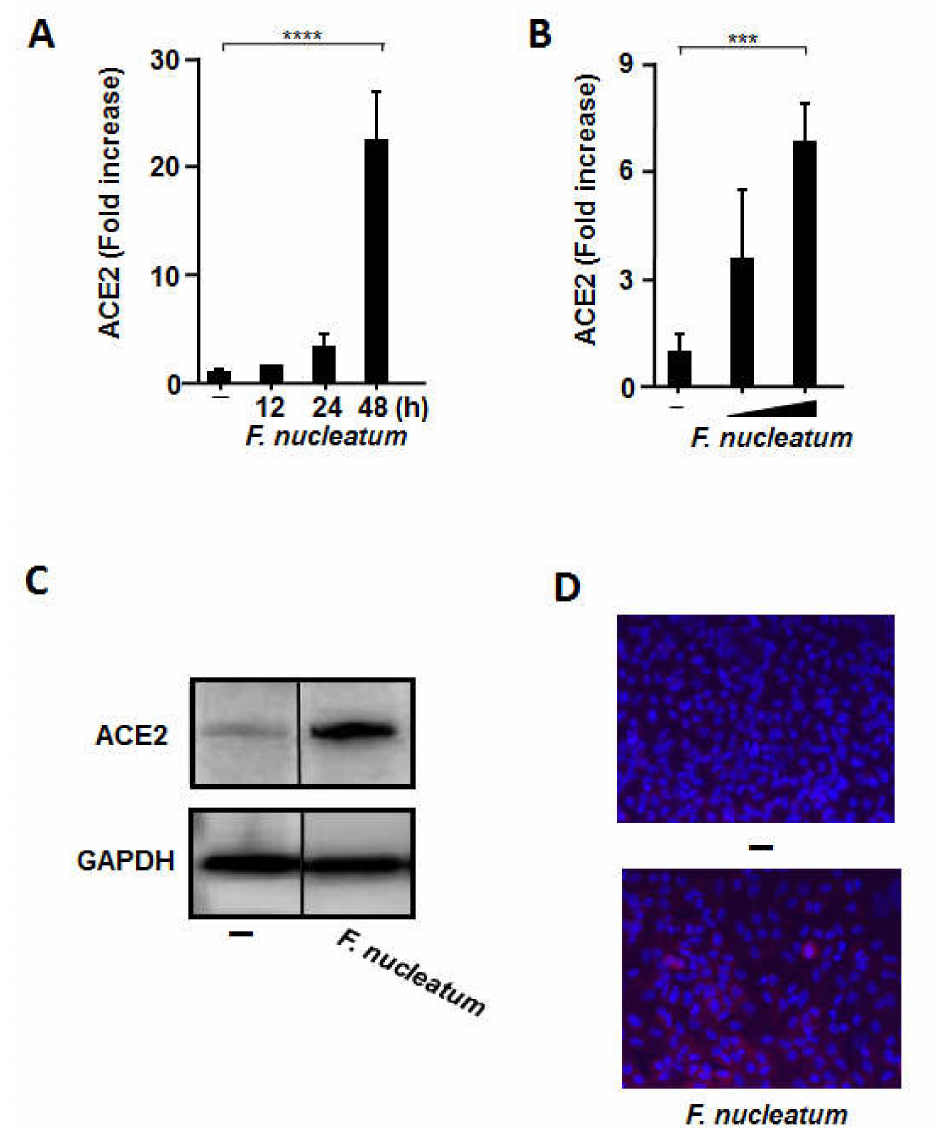
Figure 1. The culture supernatant of Fusobacterium nucleatum (CSF) upregulates angiotensin- converting enzyme 2 (ACE2) expression in A549 cells. A549 cells were incubated with or without CSF (100 µ L/mL) for the indicated times ( A ) or at different concentrations (50 or 100 µ L/mL) for 48 h ( B ). The cells were harvested, and ACE2 mRNA levels were measured using RT-qPCR with specific primers. The mRNA levels were normalized to those of glyceraldehyde-3-phosphate dehydrogenase and expressed as fold increases. These experiments were conducted in triplicate, and data are presented as the mean ± SD. ( C ) A549 cells were treated with CSF (100 µ L/mL) for 48 h. ACE2 protein expression was detected via Western blot analysis of whole cell lysates. ( D ) A549 cells were treated with CSF (100 µ L/mL) for 24 h. ACE2 protein expression on A549 cells was detected via immunofluorescence analysis. Depicted are the merged images of ACE2 (red) and nucleus (blue). The values are presented as the mean ± SD; n = 3 (***, p < 0.005; ****, p <